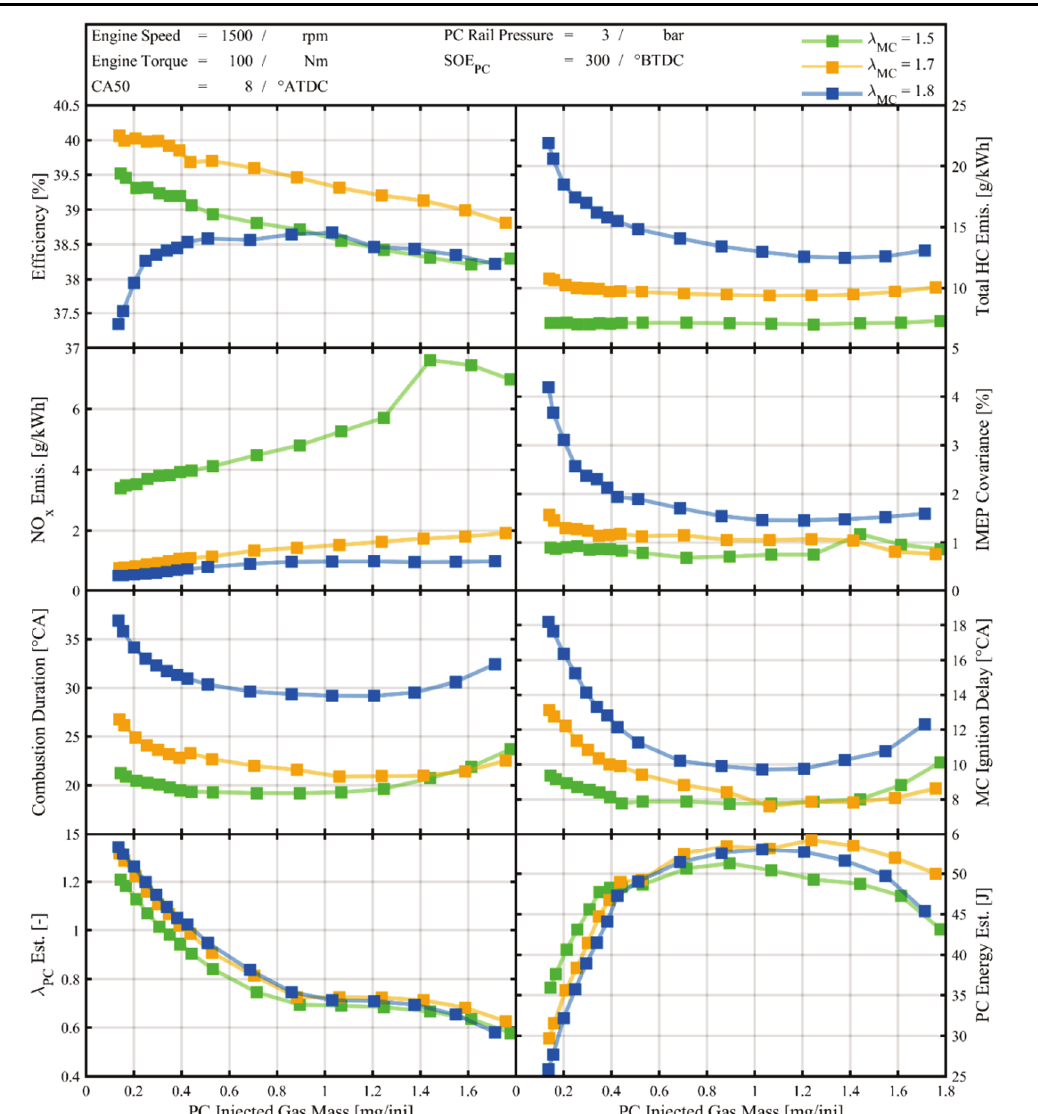
Fig. 10. Comparison of the pre-chamber injection variation depicted in Fig. 9 measured at λ MC = 1.8 with injection variations measured at λ MC = 1.5 and